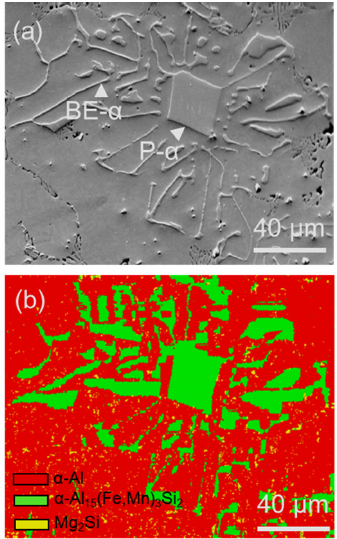
Figure 4. The Chinese script eutectic α -Al 15 (Fe,Mn) 3 Si 2 is nucleated from the compacted primary α - Al 15 (Fe, Mn) 3 Si 2 . ( a ) SEM-SEI image, and ( b ) EBSD maps of Al-5Mg-2Si-0.6Mn-1.3Fe alloys solidified at 3.5 K/s from a pouring temperature of 720 ◦ C, showing a compacted Al 15 (Fe, Mn) 3 Si 2 particle has same orientation with the Chinese script α -Al 15 (Fe, Mn) 3 Si 2 in binary eutectic